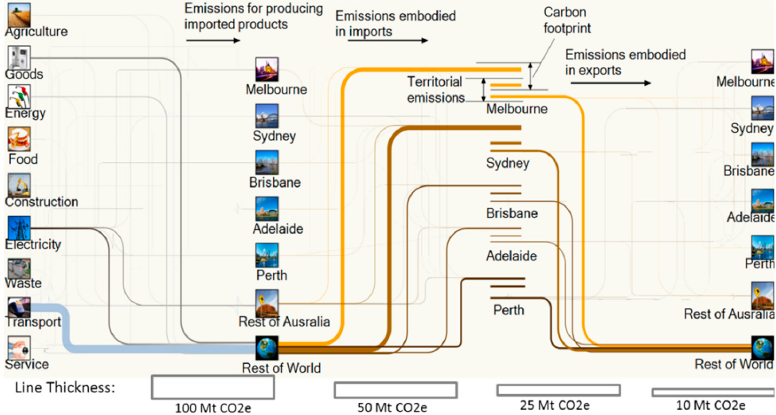
Figure 4. Flows of embodied GHG emissions related to city final demand for transport.